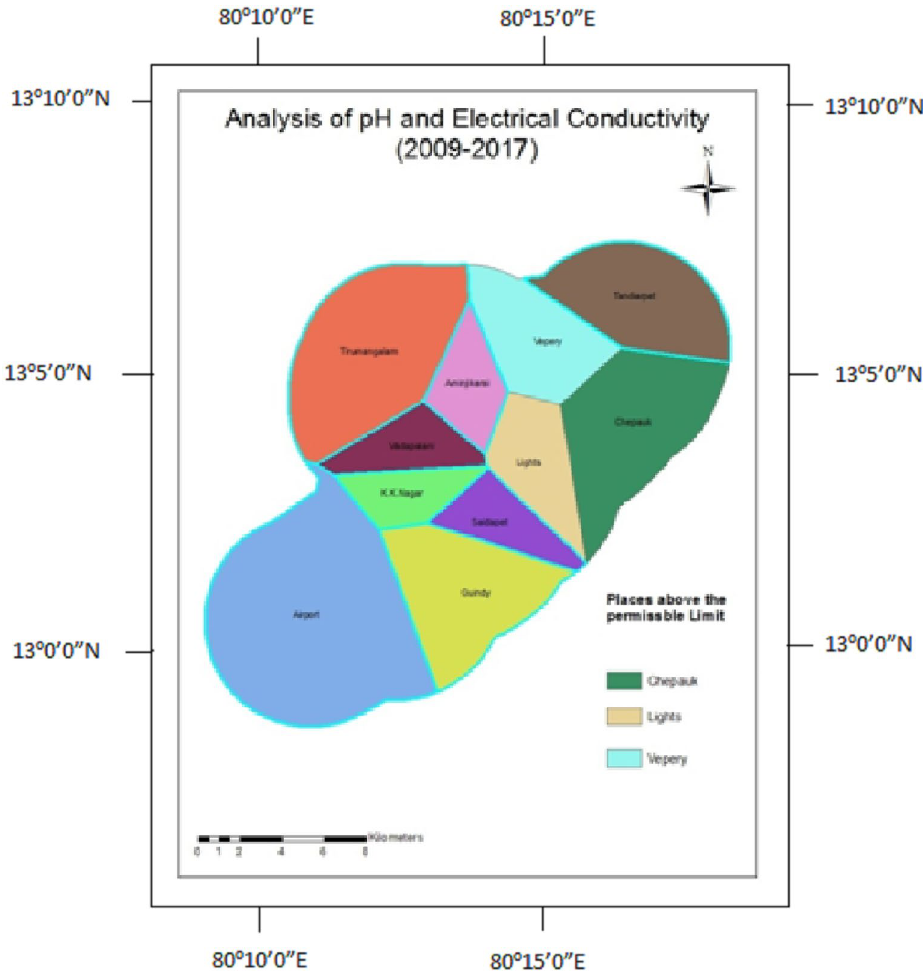
Figure 10. Analysis of pH and electrical conductivity for